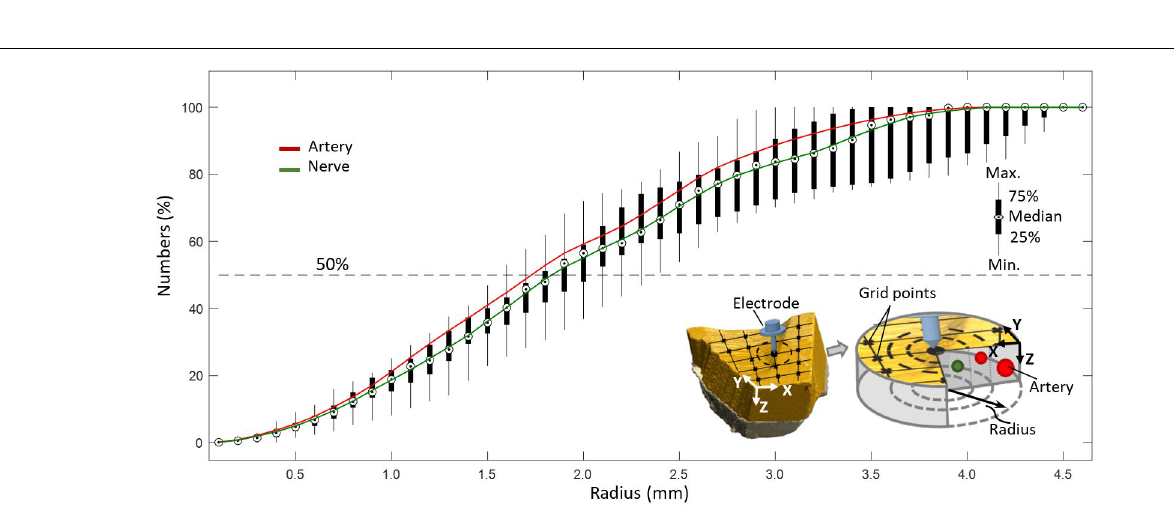
localization of aVN (Peuker and Filler, 2002; He et al.,